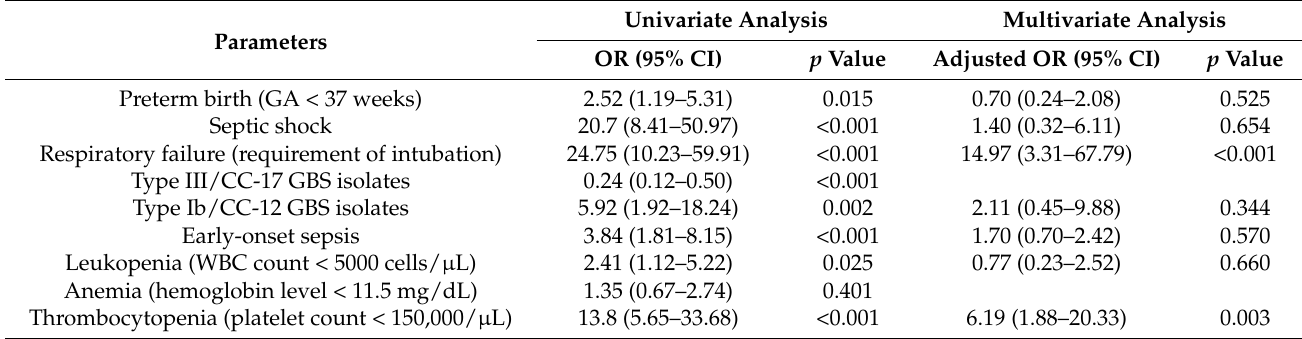
Figure 3. The percentage of complicated group B streptococcal sepsis, GBS meningitis and mortality rate of neonatal invasive GBS diseases from 2003 to 2020. Table 3. Risk factors for final unfavorable outcomes (death or major neurological sequelae at discharge) by univariate and multivariate